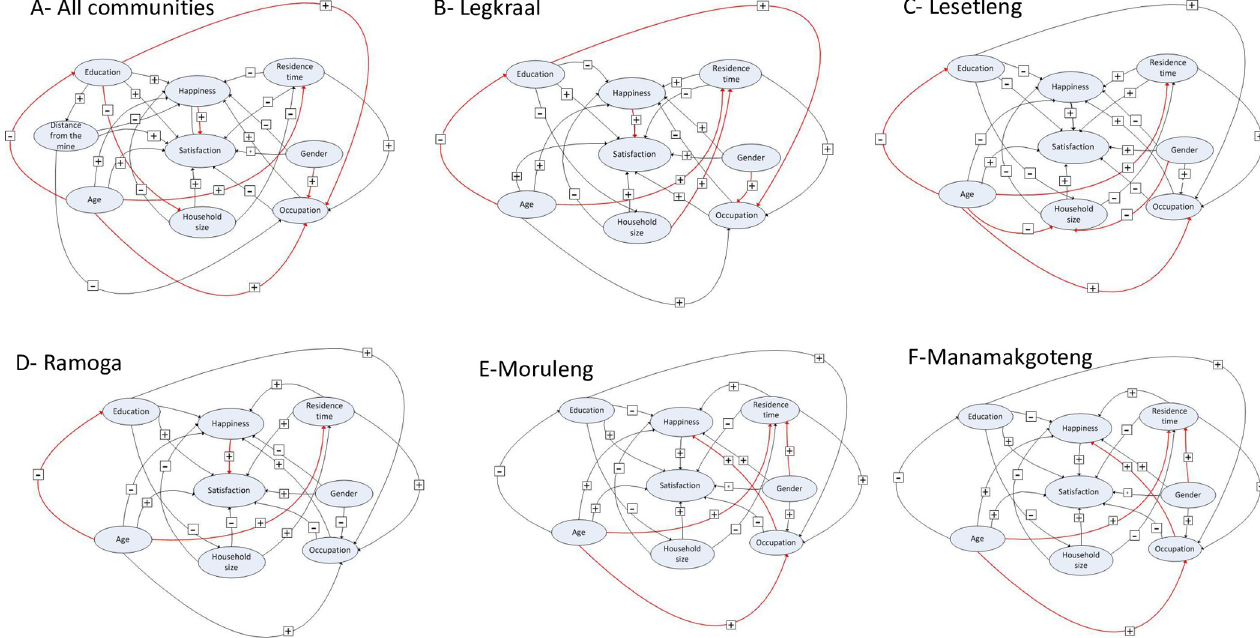
Fig 4. Structural equation model (SEM) illustrating the complex relationships between socio-demographic factors and people’s perspectives on mining business. “Happiness” is the variable used to assess whether people were initially happy when they heard for the first time about the establishment of a mining business in their communities; “Satisfaction” stands for whether people are satisfied or not of the services delivered by the mining business. “Occupation” stands for professional occupation (people are employed or not). A- When data from all five communities are combined; B- Legkraal community, C- Lesetleng community, D-Ramoga, EMoruleng, F-